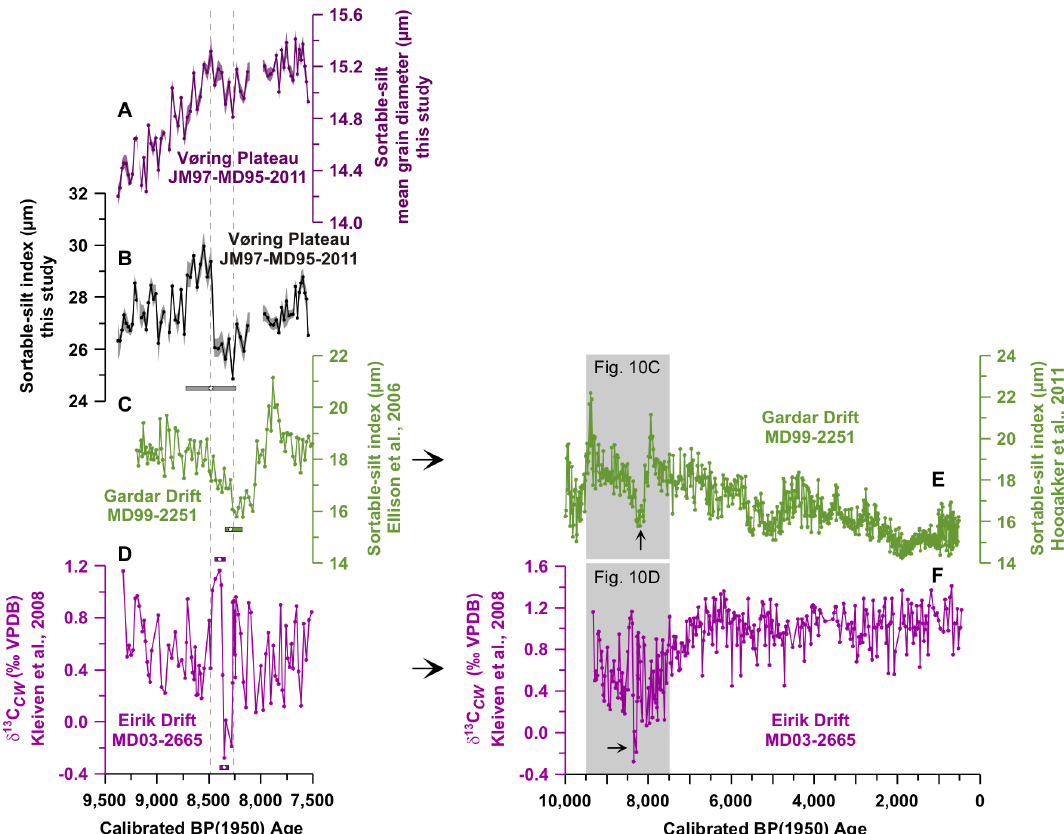
Figure 10. The temporal evolution and magnitude of the response of ocean circulation. The slowing-down of the NwASC as suggested (a) by variations in sortable-silt mean grain diameters and (b) by changes in the sortable-silt index from sediment cores JM97-MD95- 2011. (c) The sortable-silt index record from MD99-2251 representing variations in the strength of the NEADW (Ellison et al., 2006a). (d) The benthic carbon-isotope record from MD03-2665 potentially indicating the sourcing and age of bottom waters at the site (H. F. Kleiven, personal communication, 2012). The horizontal bars below the records denote the ± 1 σ errors in the respective age models. (e) The complete sortable-silt index record from MD99-2251 (Hoogakker et al., 2011b). The segment shown in Fig. 10c is highlighted in grey shading. (f) The complete benthic carbon-isotope record from MD03-2665 (H. F. Kleiven, personal communication, 2012). The segment shown in Fig. 10d is highlighted in grey